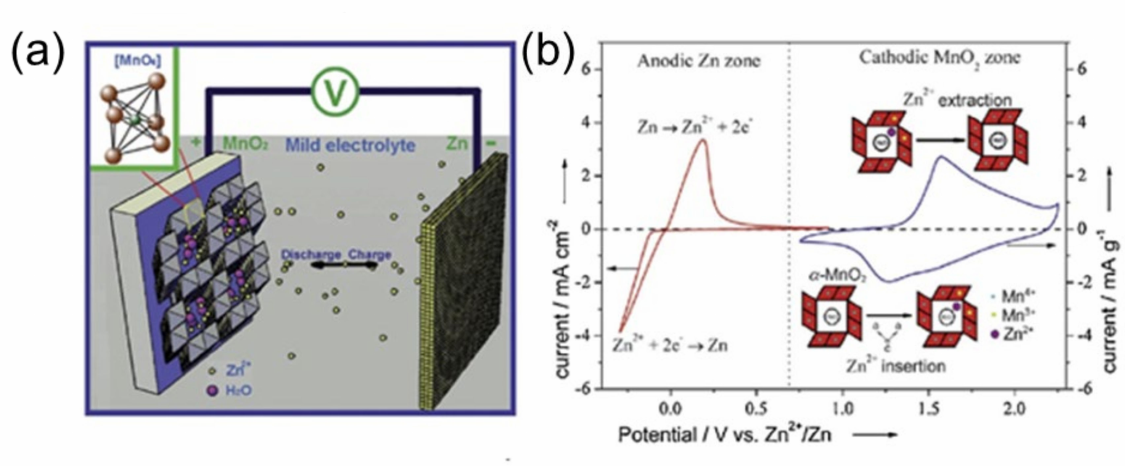
Figure 2. ( a ) A schematic illustration of aqueous ZIBs. ( b ) Zn storage mechanism of Zn/MnO 2 system at anode and cathode sides. Reprinted with permission from Ref. [34]. Copyright 2011